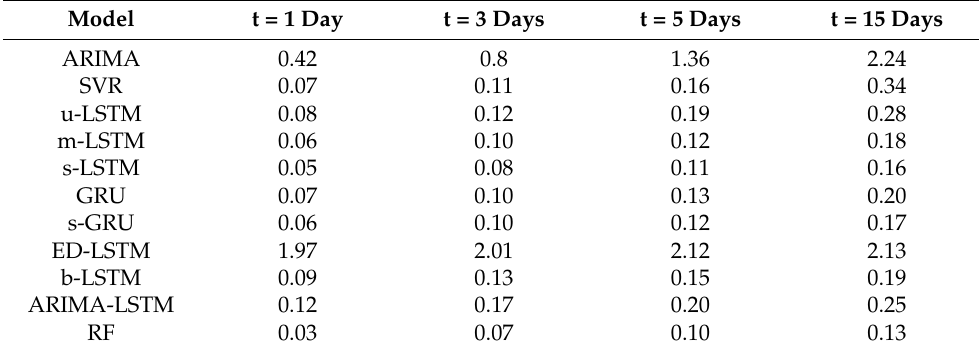
Table 1. Performance results of different forecasting models.